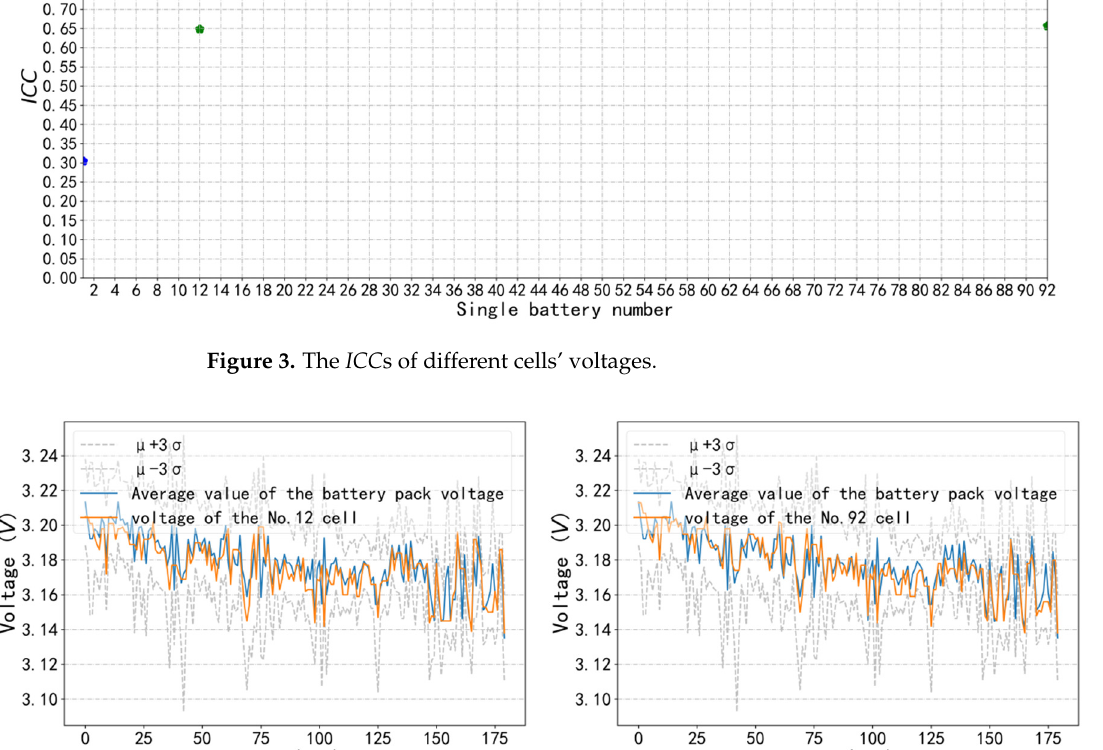
Figure 4. Graphs of the voltage of single batteries over time.